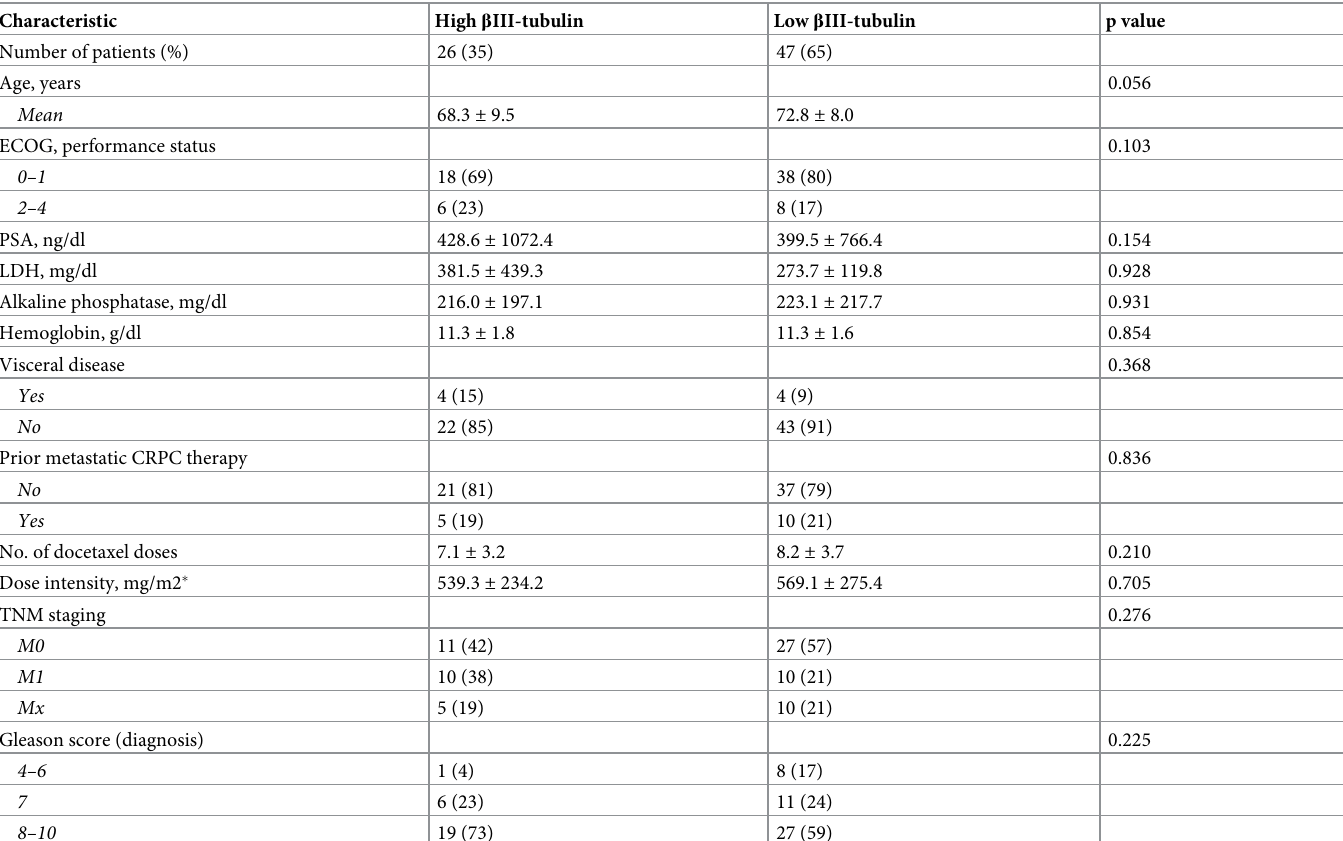
Table 2. Clinical and pathological characteristics at the time of initiation of docetaxel